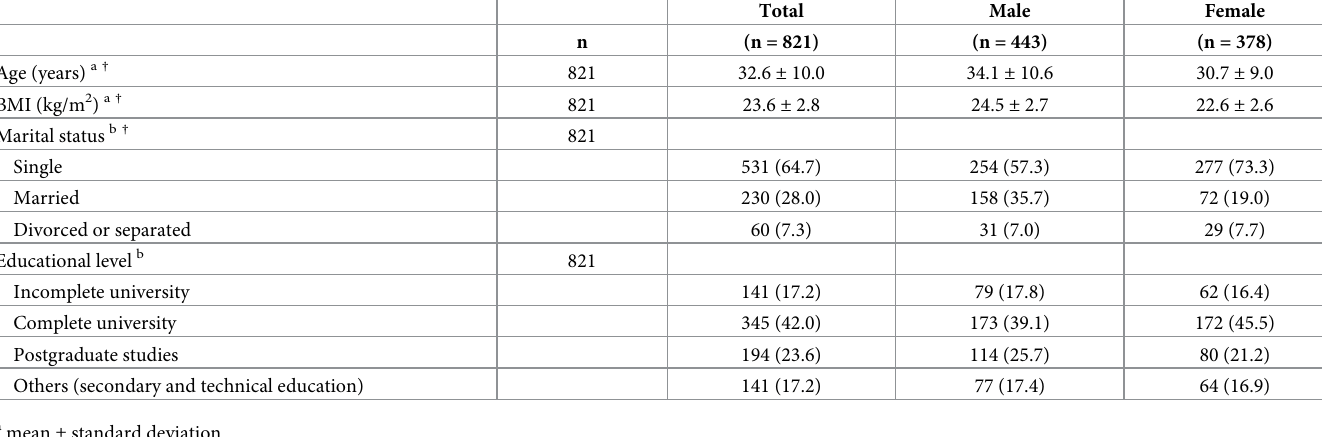
Table 1. Socio-demographic and anthropometric characteristics according to sex in SeRUN 1 study